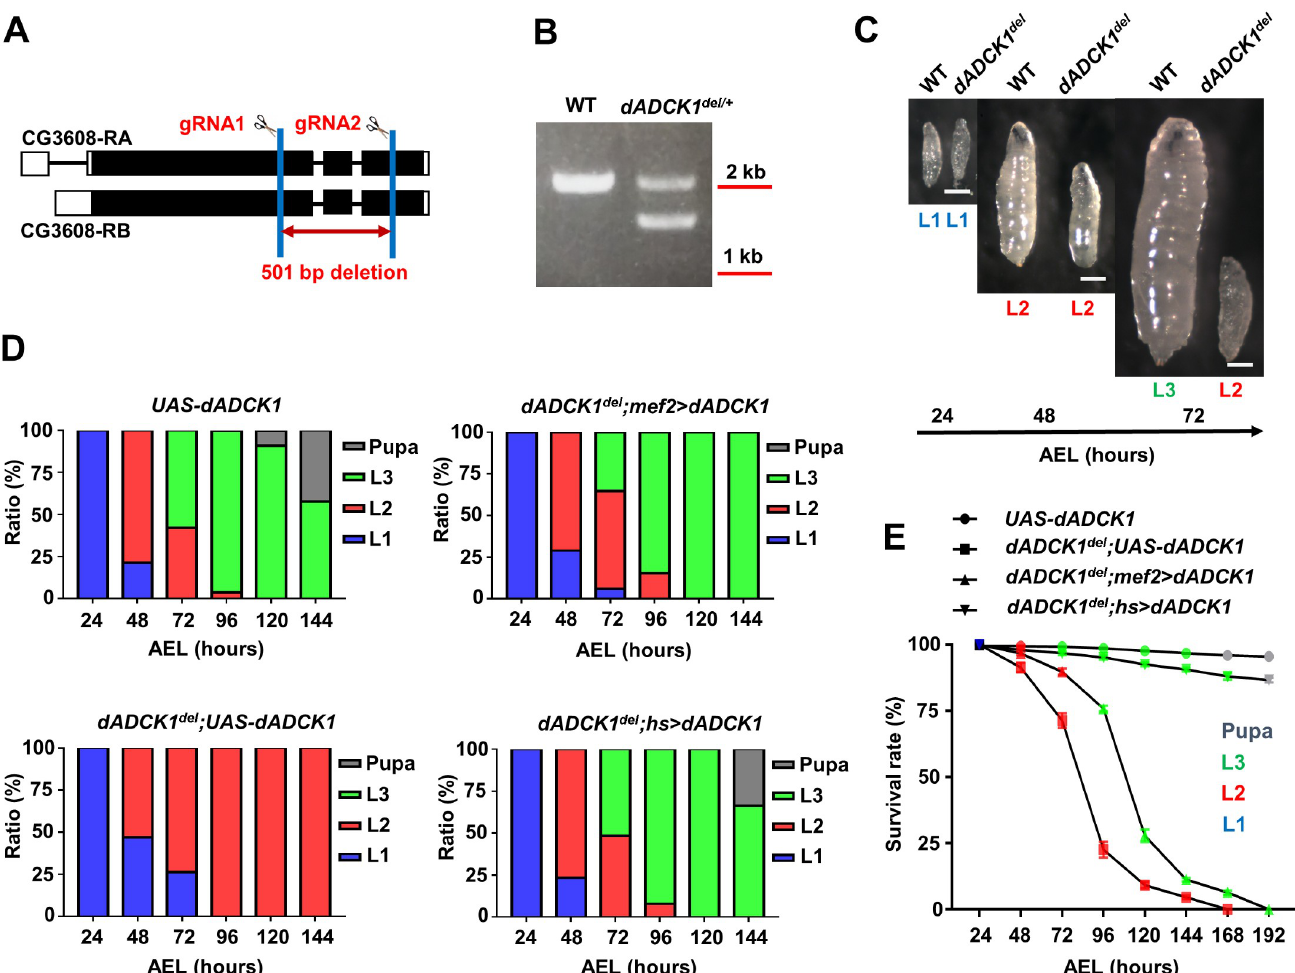
Fig 1. ADCK1 mutant flies show development defects. (A) A scheme to generate a dADCK1 deletion allele ( dADCK1 del ) by CRISPR/Cas9. (B) A DNA gel electrophoresis result for the genomic DNA of wild type (WT) and heterozygous dADCK1 mutant allele ( dADCK1 del/+ ). (C) Comparison of the body size and developmental stages between WT (left) and dADCK1 del (right) flies. WT flies were first instar (L1), second instar (L2), and third instar (L3) larvae at 24, 48, and 72 hours after egg laying (AEL), respectively. dADCK1 del flies in these photos were first instar and second instar larvae, collected at the same time points. Scale bars, 0.1 mm. (D) Developmental progression of the flies with indicated genotypes. n = 375~403. (E) Comparison of the viability of the flies with indicated genotypes. n = 375~403. Statistical significance was analyzed by log-rank (Mantel-Cox) test. p < 0.0001. Color-coded symbols indicate specific developmental